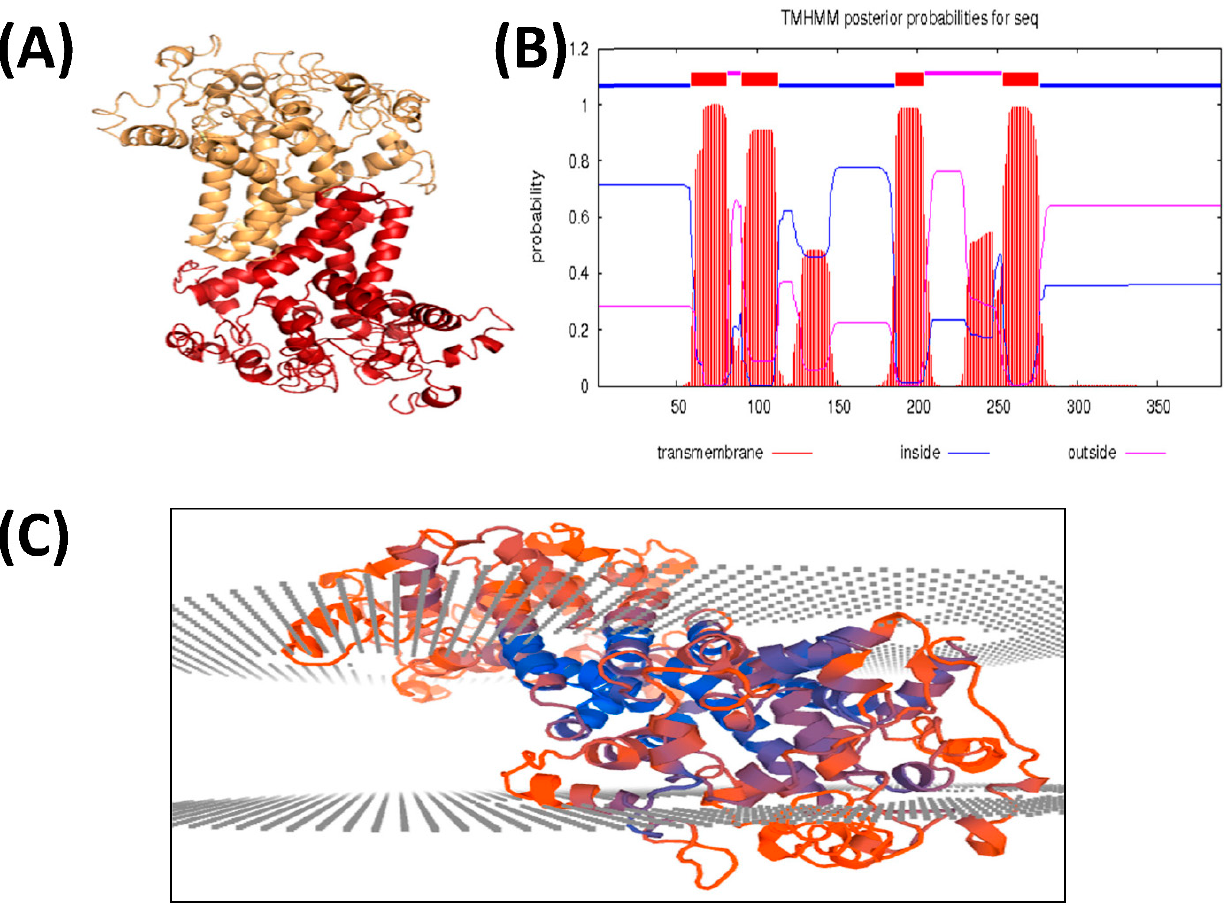
Table 5. Peptidic composition and physico-chemical features of the EoFAD2 protein.